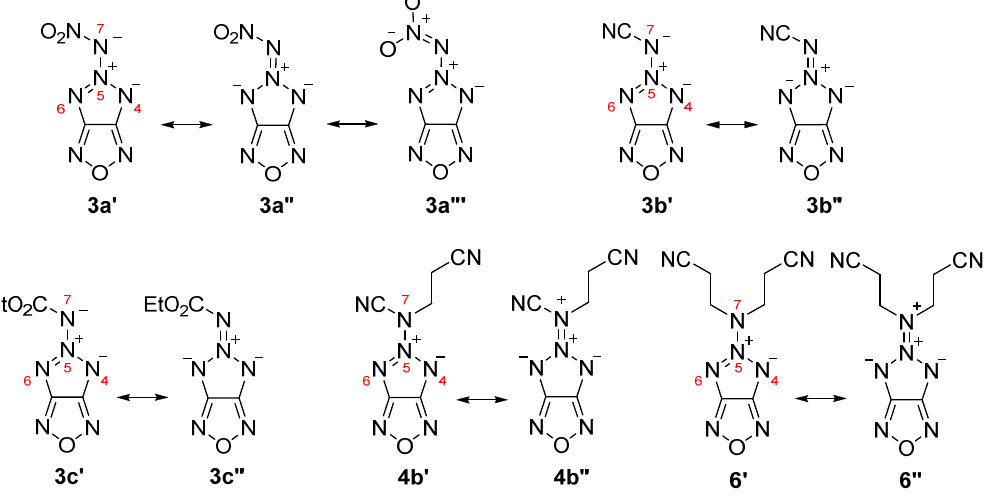
Figure 5. Resonance structures of compounds 3a – c, 4b , and 6 . Table 1. Selected bond lengths of compounds 3a – c , 4b , and 6 .